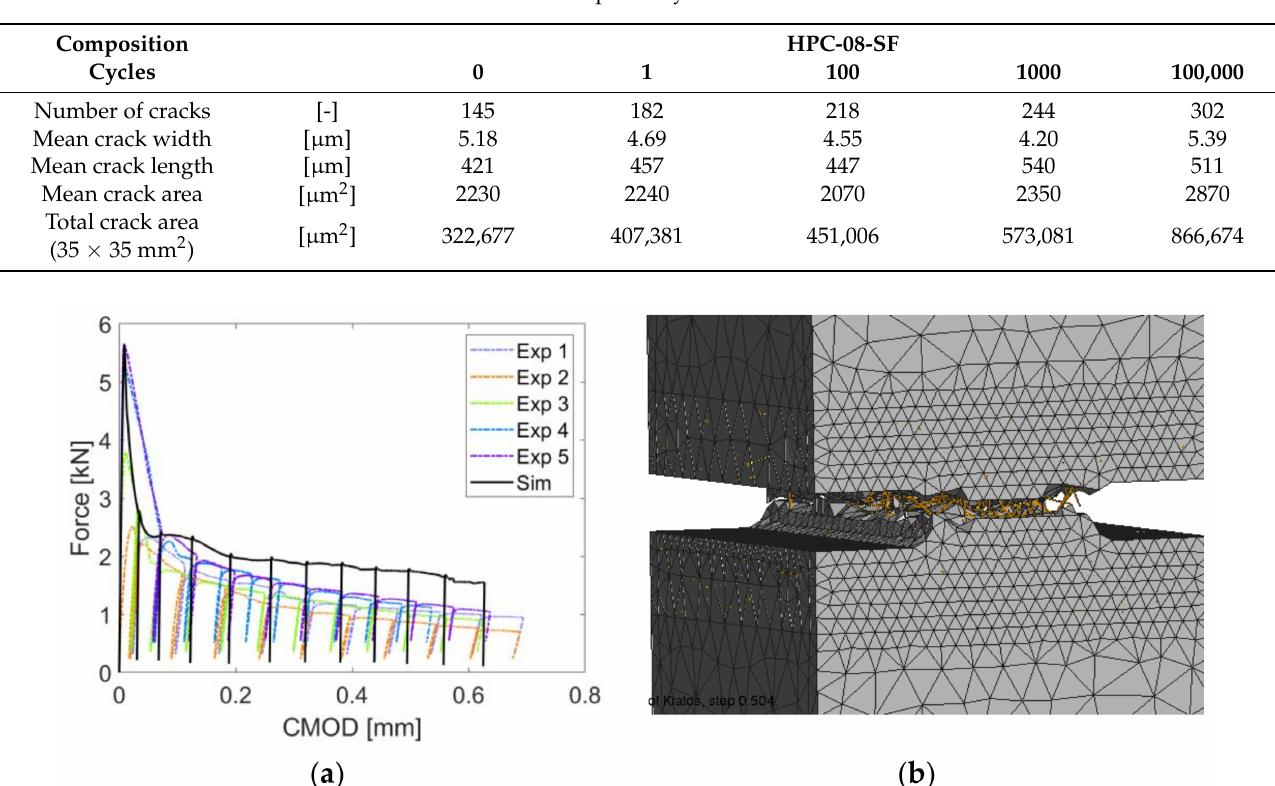
Table 7. Microscopic analysis of HPC-08-SF.